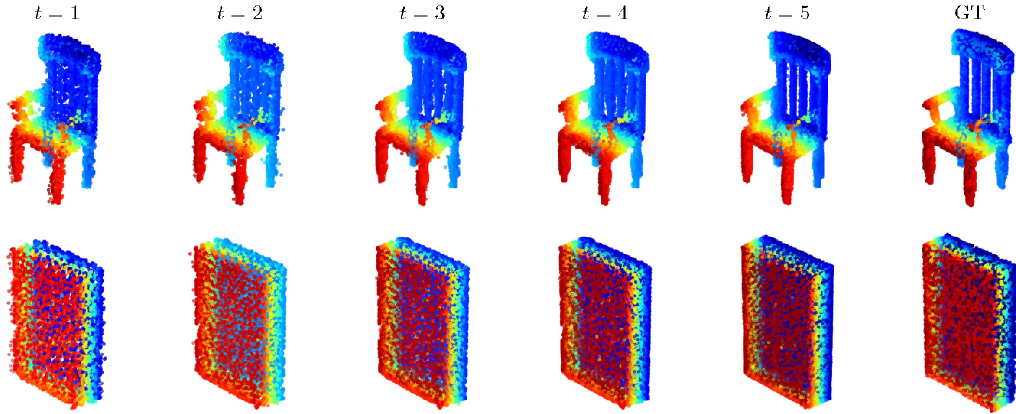
Fig. 11 Example shape completion results using the ShapeNet dataset regressed from the intermediate features in